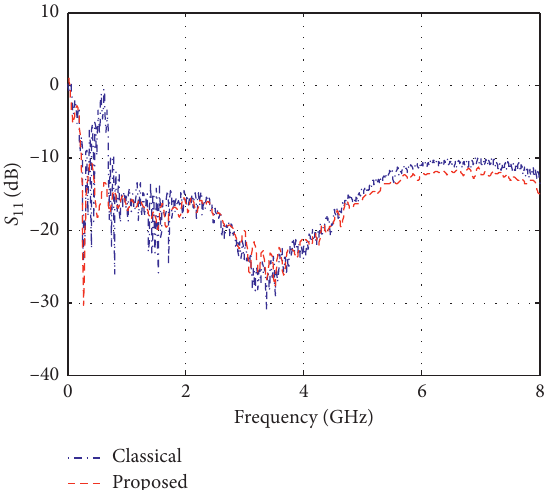
Figure 3: Simulated reflection coefficient of antennas with different arm